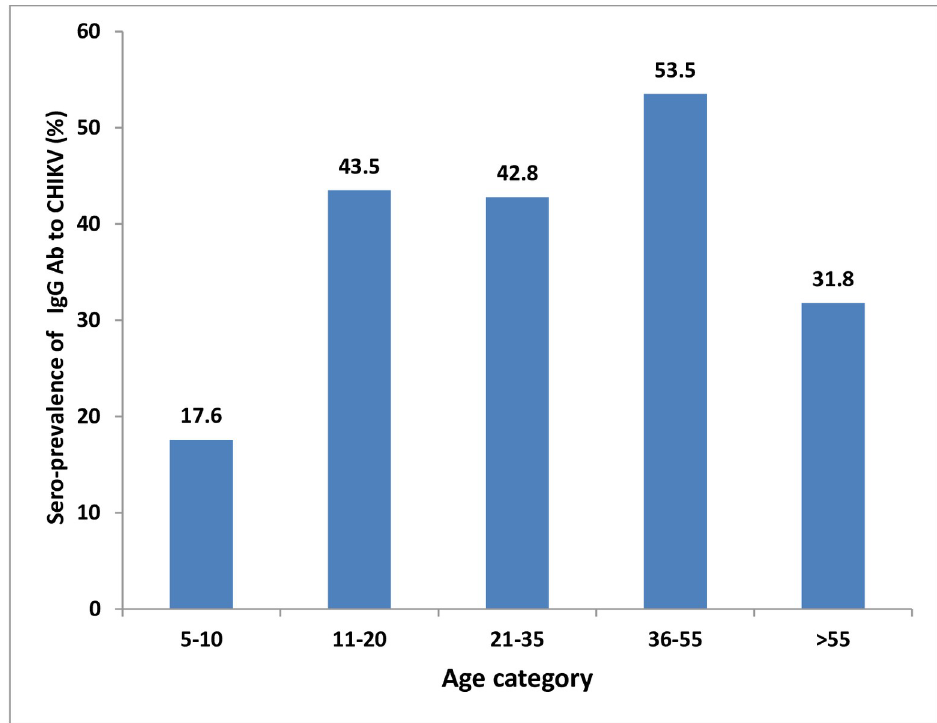
Fig 1. Sero-prevalence of IgG antibody to CHIKV by age